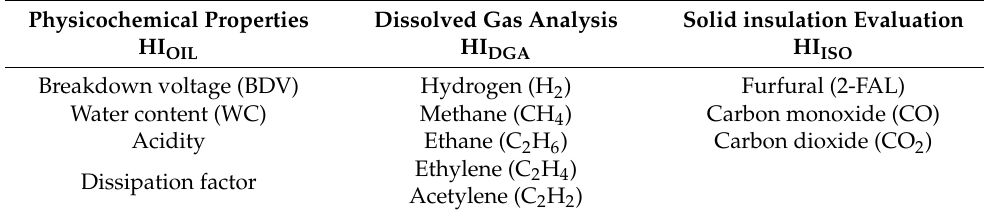
Figure 3. The overall scheme of the health index analysis. Table 1. The parameters included in the presented health index with the subindex breakdown.